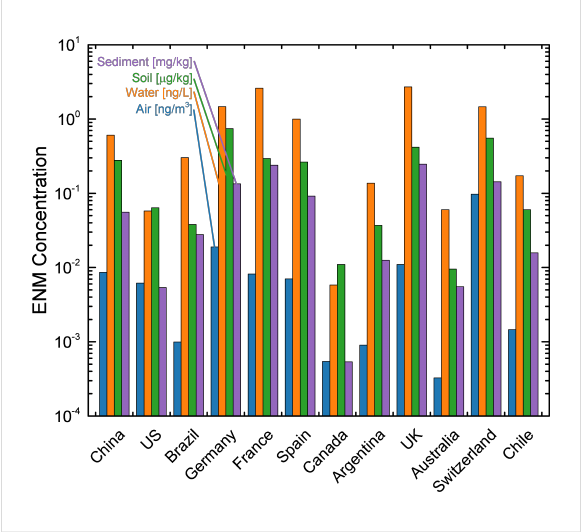
Figure 13: Predicted compartmental concentrations for CeO 2 in 12 selected countries at the end of a 1 year simulation for the ENM release rates reported in Figure 12 . Regional geographical and meteo- rological parameters are reported in Supporting Information File 1, Table